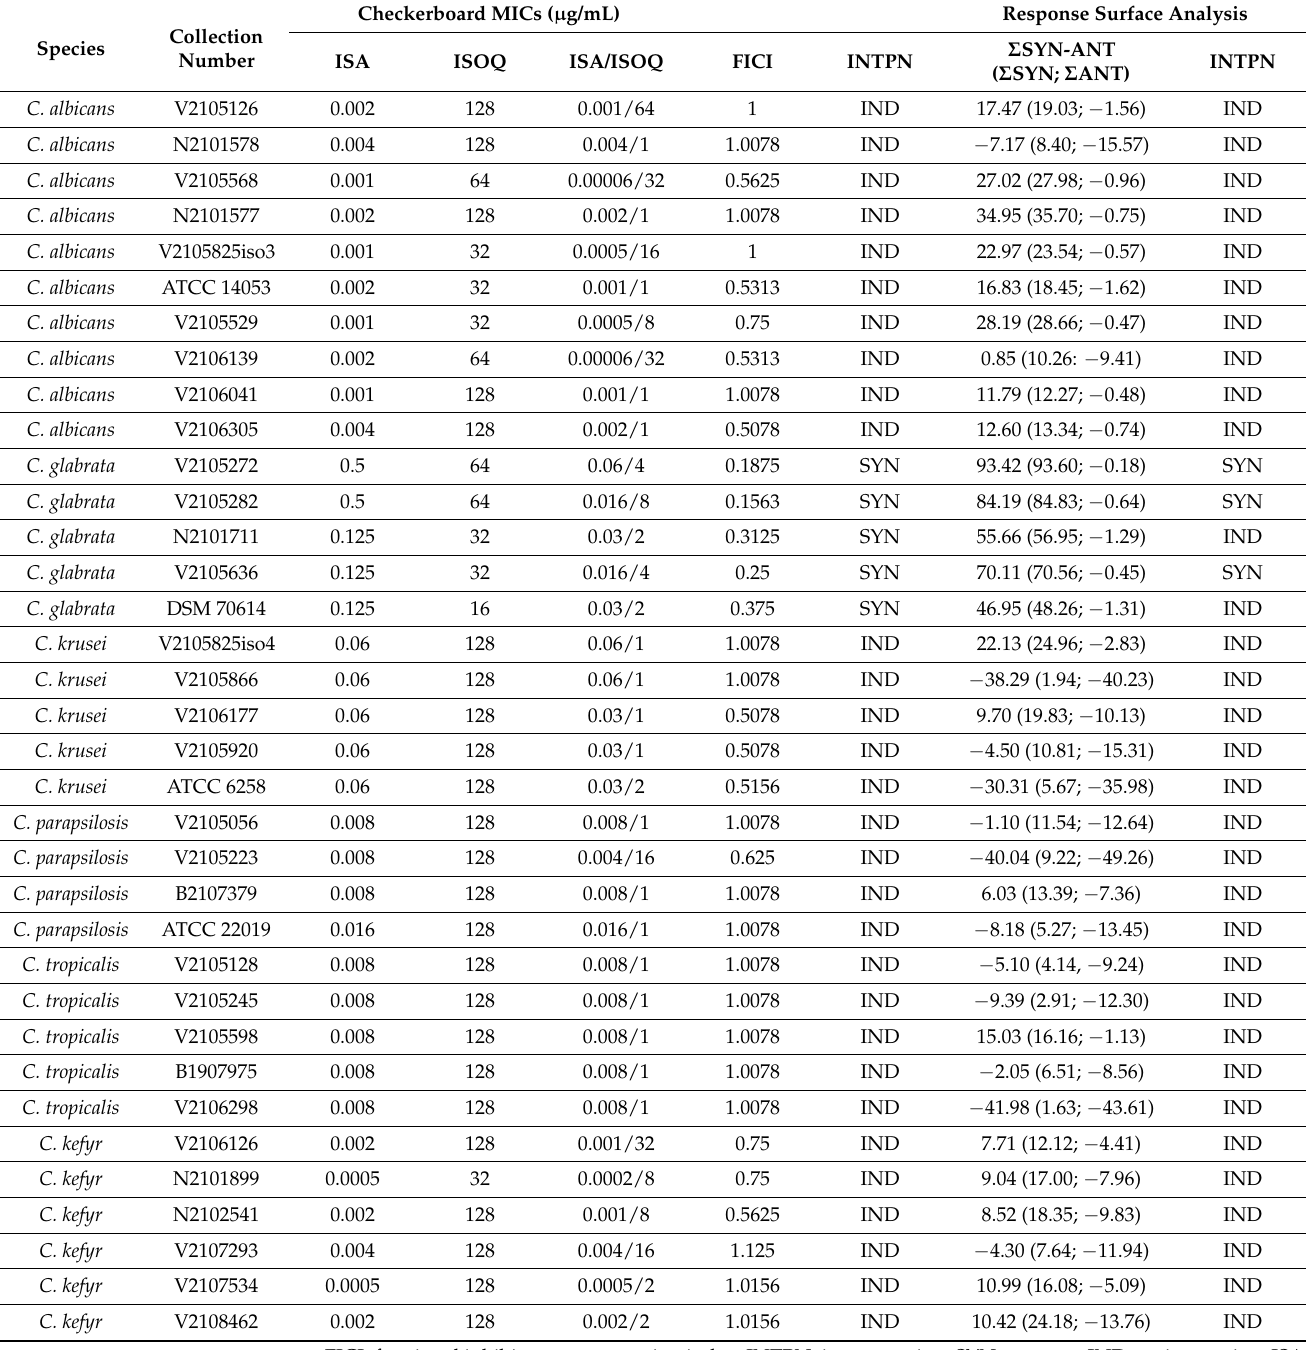
Table 1. Interaction of isavuconazole with isoquercitrin against common Candida species evalu- ated by checkerboard and interpretation by fractional inhibitory concentration index and response surface